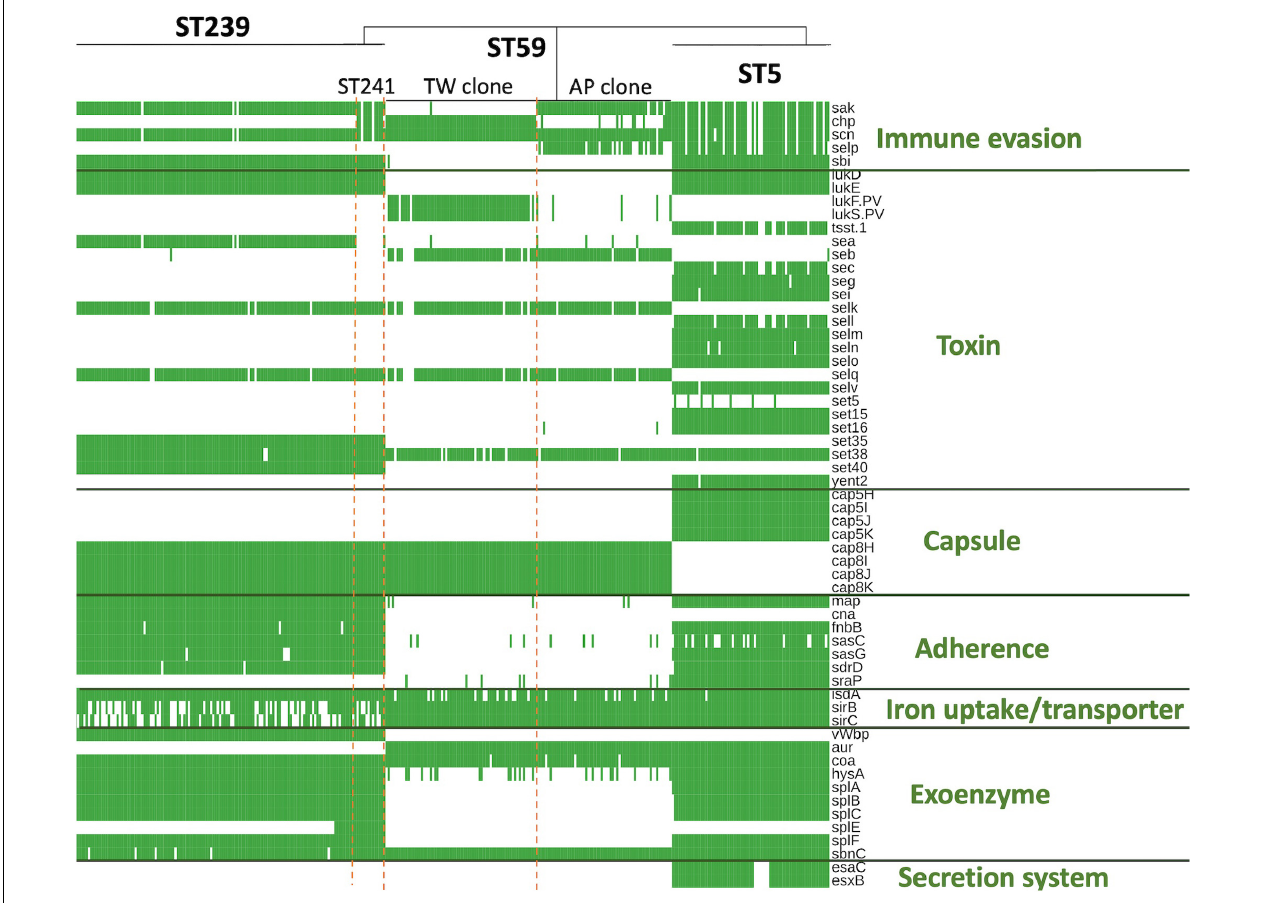
FIGURE 4 | Differentially distributed virulence factors among methicillin-resistant Staphylococcus aureus isolates of three prevalent lineages, ST239/241, ST59, and ST5, in